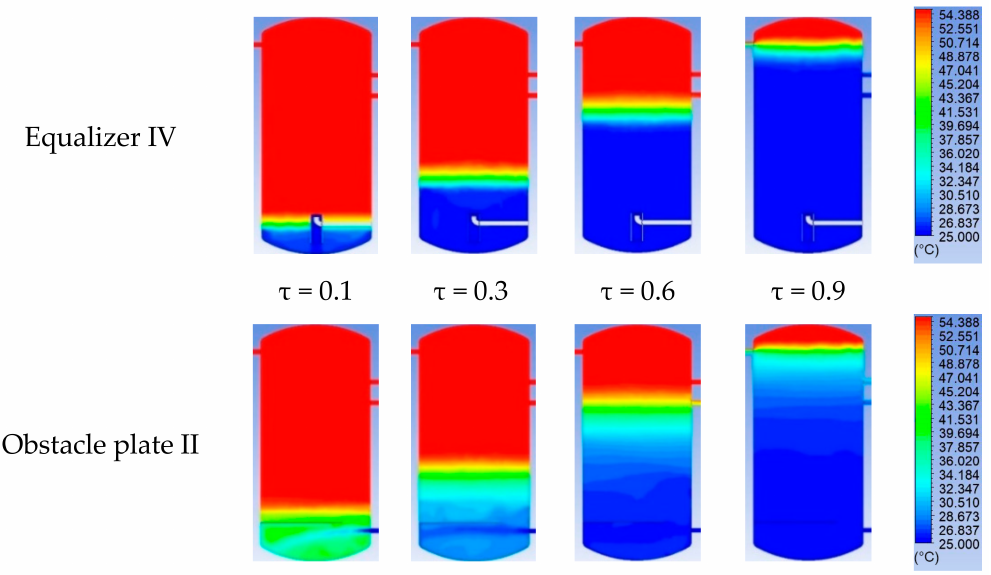
Figure 25. The temperature contours of the equalizer IV and the obstacle plate II models.